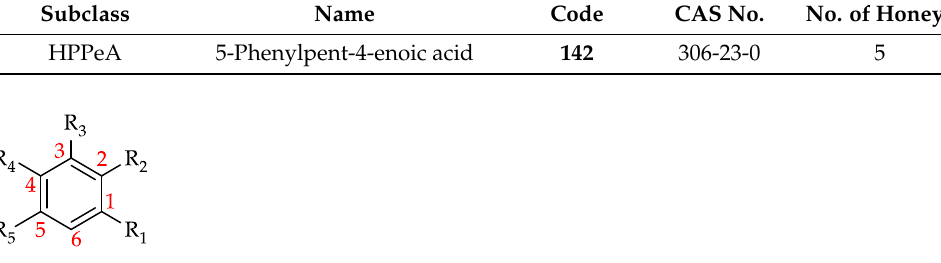
Figure 20. Basic structure of other phenolic compounds (see 143–156 in Table 14). Table 14. Alkylmethoxyphenol, alkylphenols, hydroxybenzaldehydes, hydroxybenzoketones and